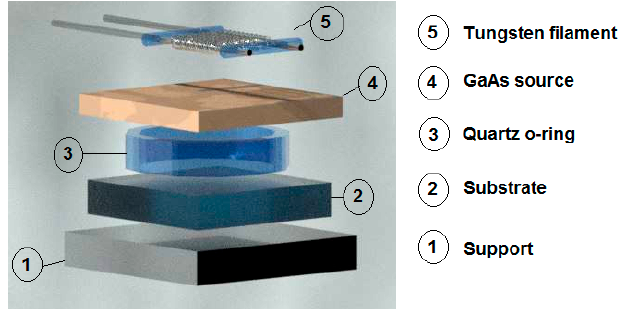
Figure 1. Typical scheme of a close-spaced vapor transport (CSVT) system.